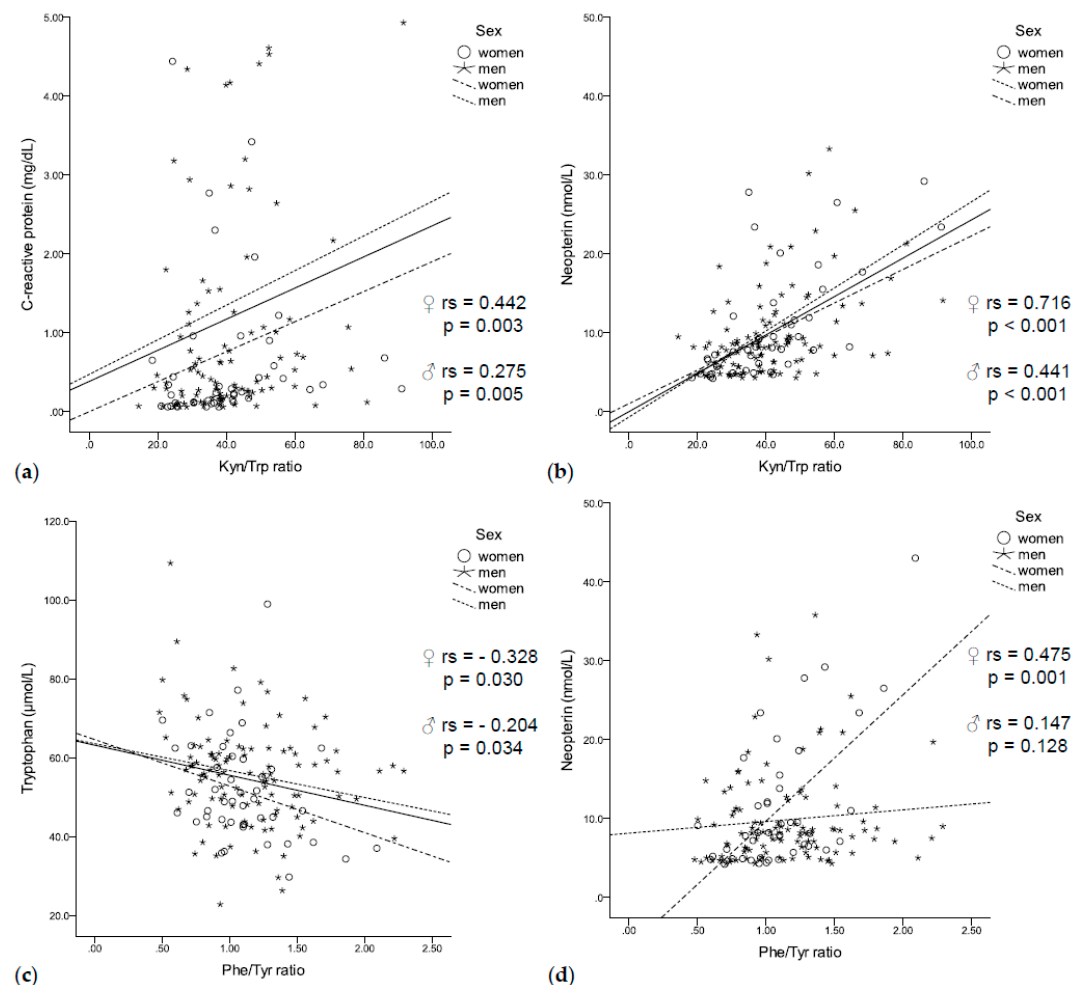
Figure 2. ( a ) The Kyn / Trp ratio was positively correlated with C-reactive protein ( b ) and neopterin concentrations independent of sex. ( c ) While tryptophan negatively correlated with the Phe / Tyr ratio independent of sex, ( d ) neopterin positively correlated with the Phe / Tyr ratio only in